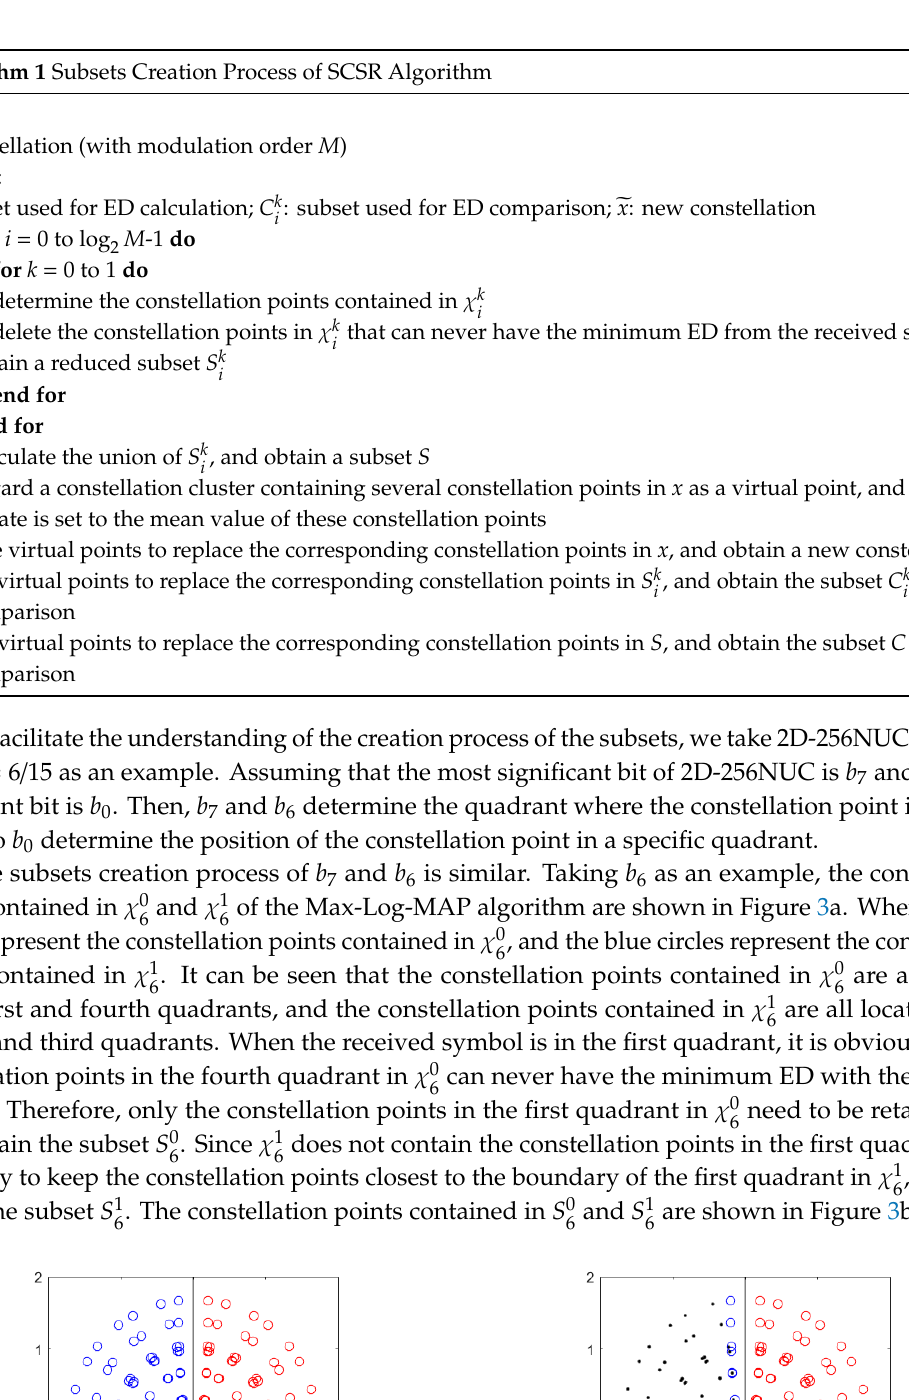
Algorithm 1 Subsets Creation Process of SCSR Algorithm